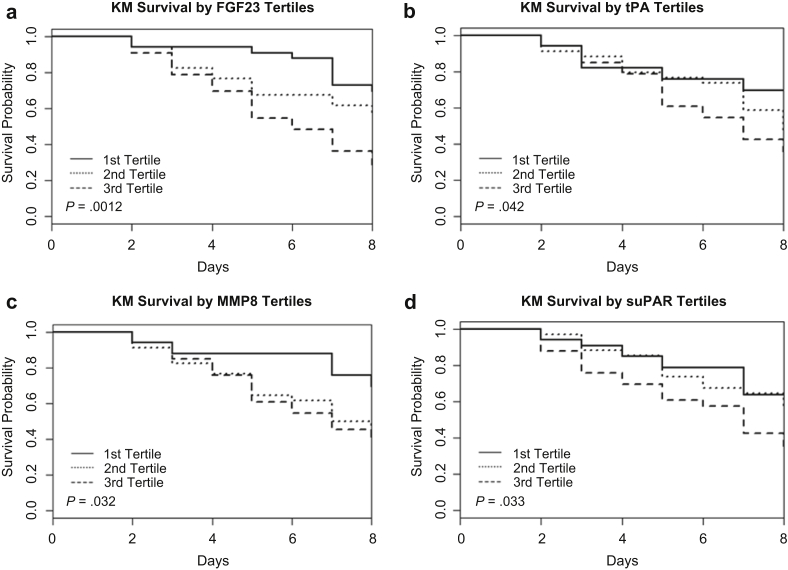
Day 1 cohort event-free survival stratified by biomarker tertiles. (a) Fibroblast growth factor 23 (FGF23), (b) tissue plasminogen activator (tPA), (c) matrix metalloproteinase-8 (MMP8), and (d) soluble urokinase plasminogen activator receptor (suPAR). KM, Kaplan-Meier.